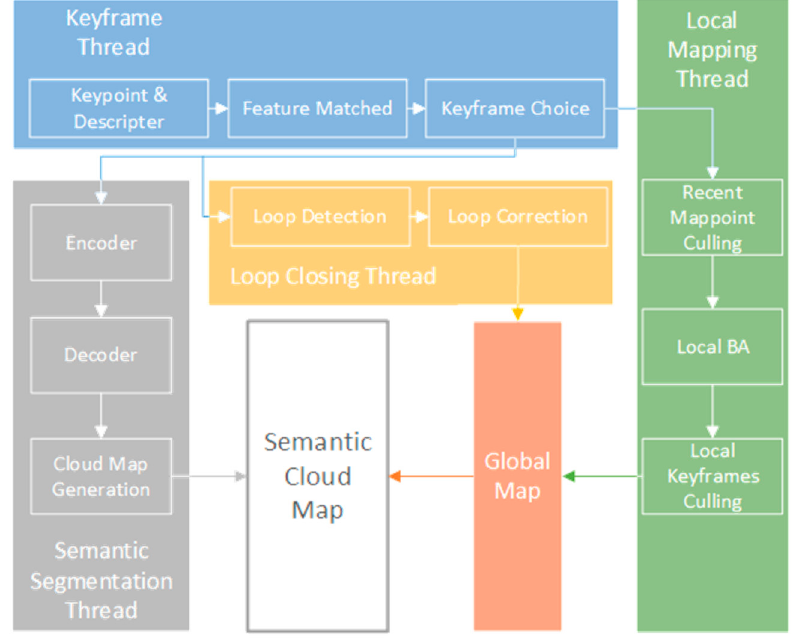
Figure 3. The framework of the proposed semantic visual SLAM system.